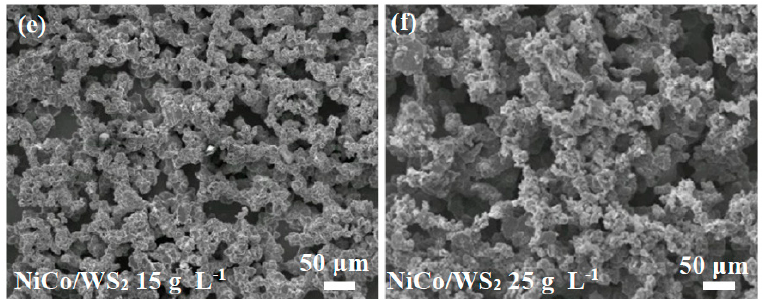
Figure 3. SEM images of the Ni-Co/WS 2 coatings deposited from solutions having controlled WS 2 concentrations: ( a ) 0 g L − 1 , ( b ) 1 g L − 1 , ( c ) 5 g L − 1 , ( d ) 10 g L − 1 , ( e ) 15 g L − 1 and ( f ) 25 g L − 1 .